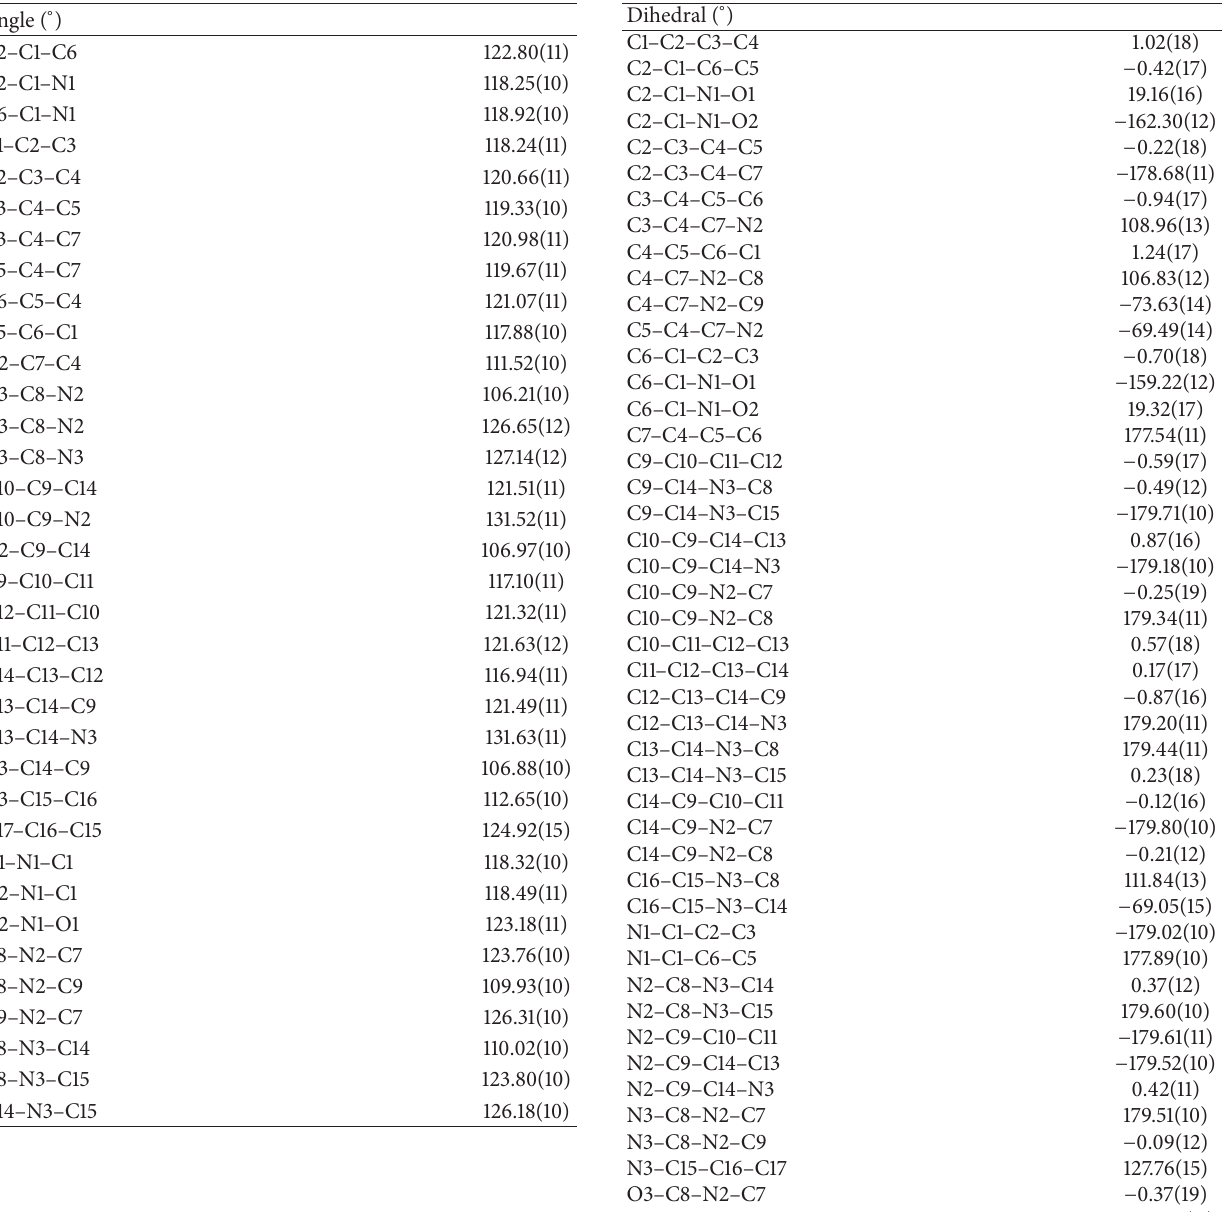
Table 3: Bond angles for 5 . Table 4: Torsion angles for 5